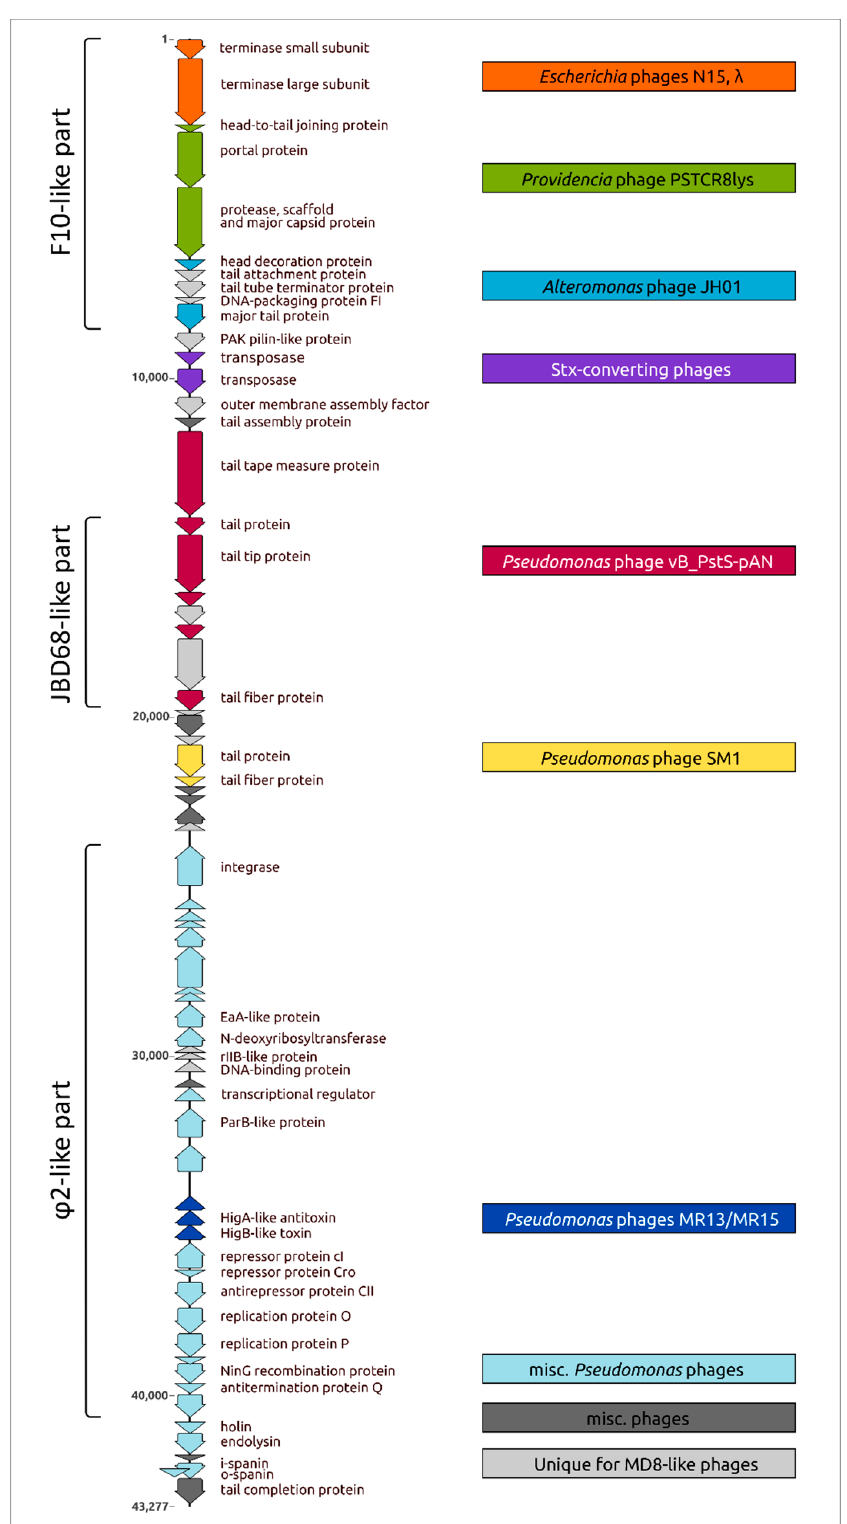
Figure 11. Genetic map of the Pseudomonas MD8 phage and genomic modules identified by sequence comparison and phylogenetic analysis. Parts of the genomes generally more similar to the F10, JBD68 and φ phages, which belong to the MD8 group, are shown in parentheses on the left. The MD8 genes are coloured corresponding the colours of boxes on the left, which contain the names of not MD8-like phages related to MD8 according to analyses of proteins encoded by these genes.